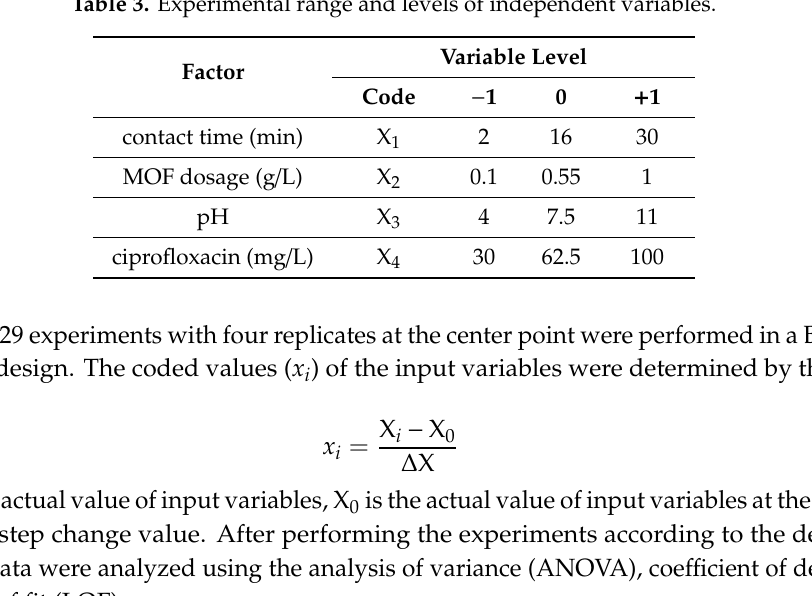
Table 3. Experimental range and levels of independent variables.